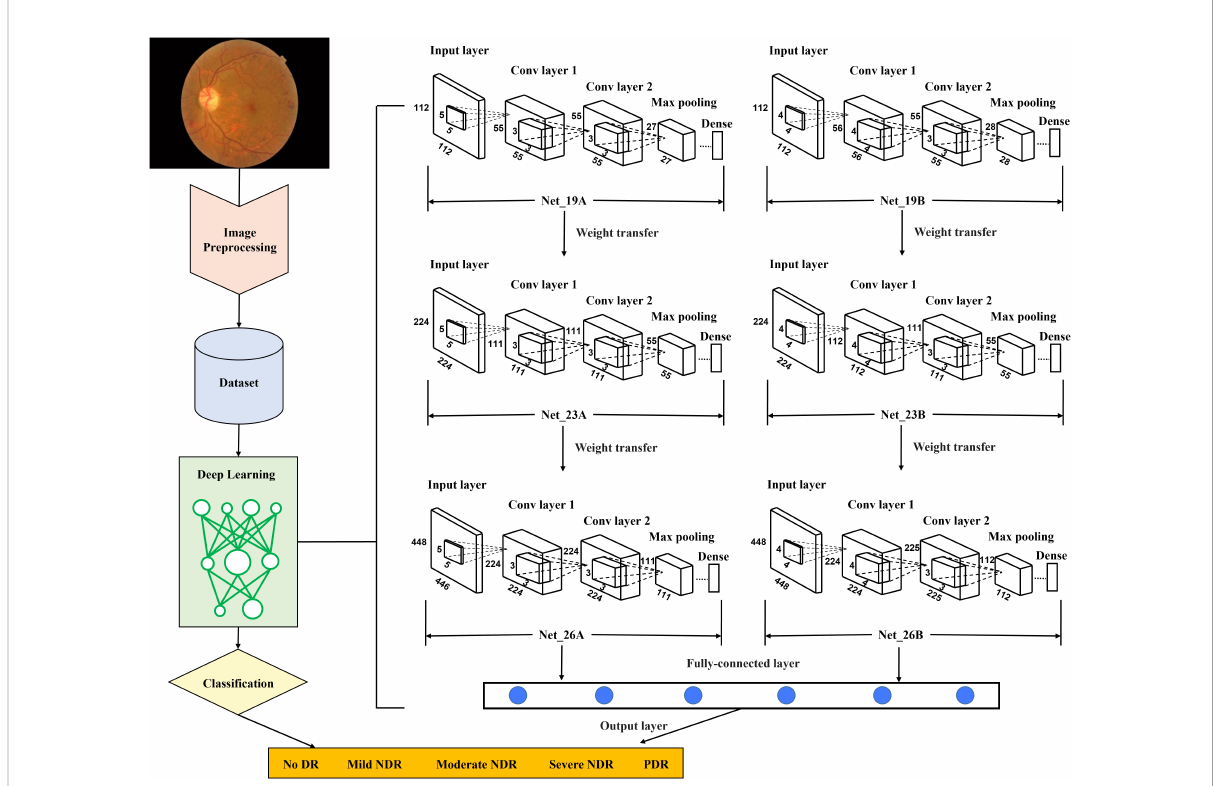
FIGURE 1 Flow diagram of the proposed retinopathy grading system. Conv, convolutional; CNN, convolutional neural network; DR, diabetic retinopathy; NDR, nonproliferative diabetic retinopathy; PDR, proliferative diabetic retinopathy. First, in the preprocessing stage, the retinal images as the training set were re-cut, and the training set was expanded to balance the proportion of fi ve grades of images. In addition, the resolution of images was adjusted, and the preprocessed images will be uni fi ed into three different resolutions for training CNN with different layers. Second, images with a resolution of 112×112 were used to train two CNNs with 19 layers, Net_19A and Net_19B. Using the transfer learning method, assign the weights of the fi rst eleven layers obtained by its training to the corresponding fi rst eleven layers in the two CNNs with 23 layers, Net_23A and Net_23B. Images with a resolution of 224×224 were used to train Net_23A and Net_23B. The weights of the fi rst fi fteen layers obtained after training are assigned to the fi rst fi fteen layers of the two CNNs with 26 layers, Net_26A and Net_26B. Then images with a resolution of 448×448 were used to train Net_26A and Net_26B. Third, after all the training of the CNN was completed, the output features of the last pooling layer in the two network models of Net_26A and Net_26B were extracted and saved. Finally, the extracted features were used as input data to train the fi nal fully connected network